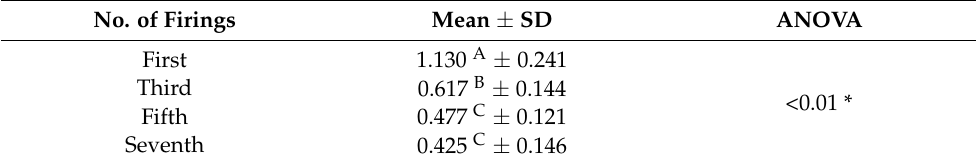
Table 3. Means and standard deviations for Ra after the third, fifth, and seventh firing.